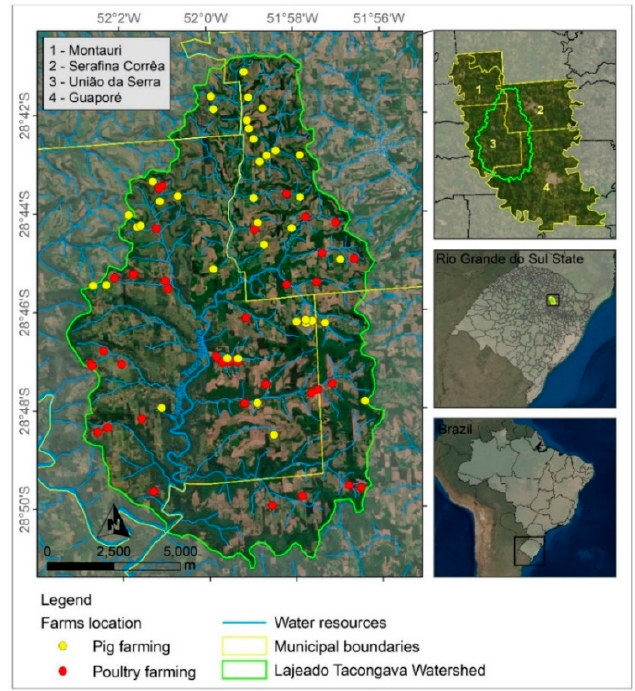
Figure 1. Lajeado Tacongava watershed and farm locations.